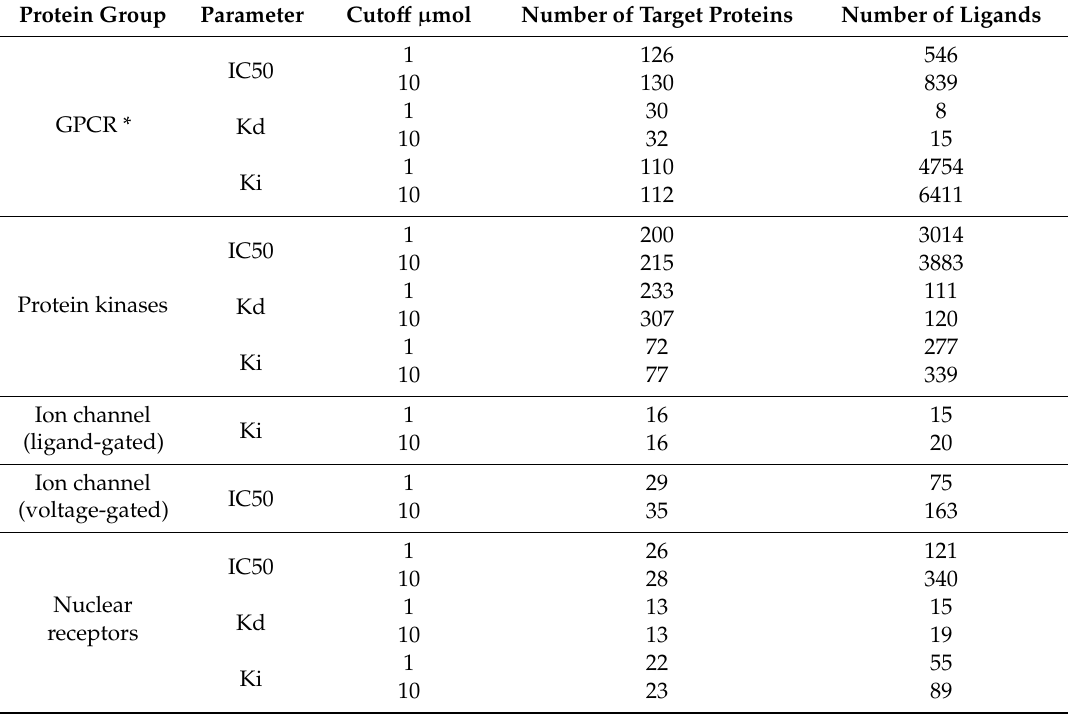
Table 1. Characteristics of the training sets representing the protein–ligand